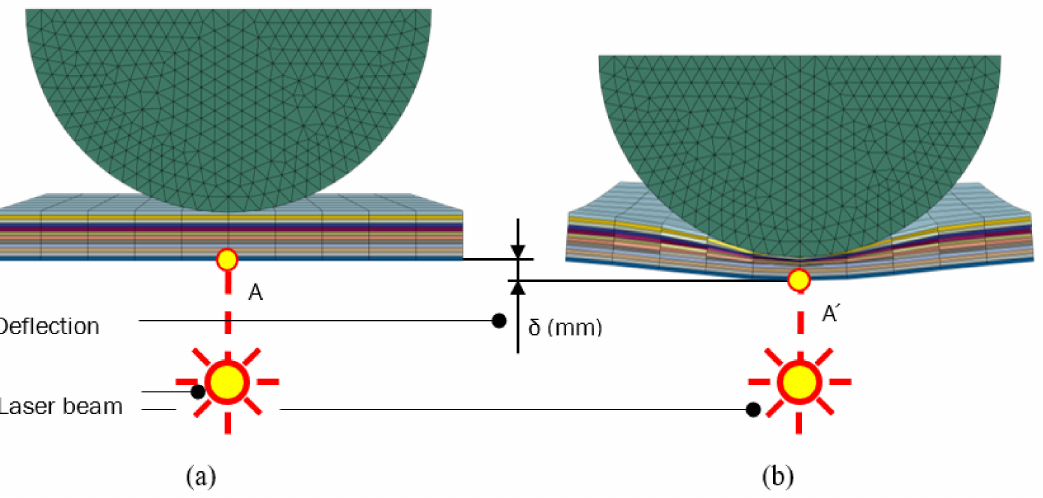
Figure 5. Deflection under the impactor from the simulation results; Initial state of impact ( a ); Maximum plate displacement under impactor ( b ).